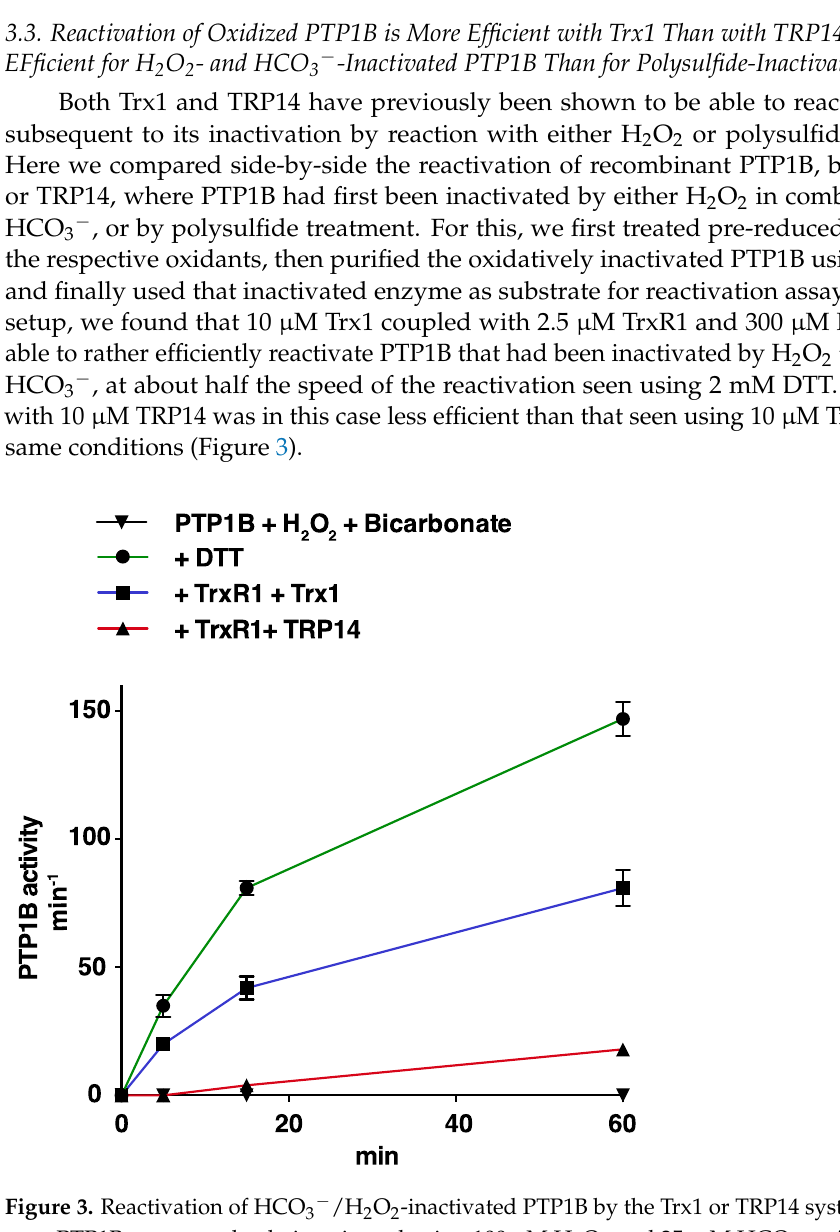
Figure 3. Reactivation of HCO 3 − /H 2 O 2 -inactivated PTP1B by the Trx1 or TRP14 systems. Recombi- nant PTP1B was completely inactivated using 100 μ M H 2 O 2 and 25 mM HCO 3 − . After desalting,